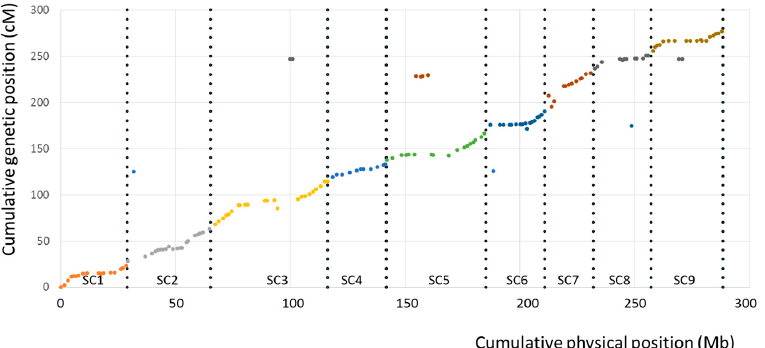
Figure 5. Marey map plot constructed with the 159 genetically mapped SNPs; x axis, physical positions on the clementine reference genome (the dotted vertical lines delimit the 9 scaffold); y axis, positions on the tetraploid citrumelo genetic map. Each color corresponds to one linkage group.